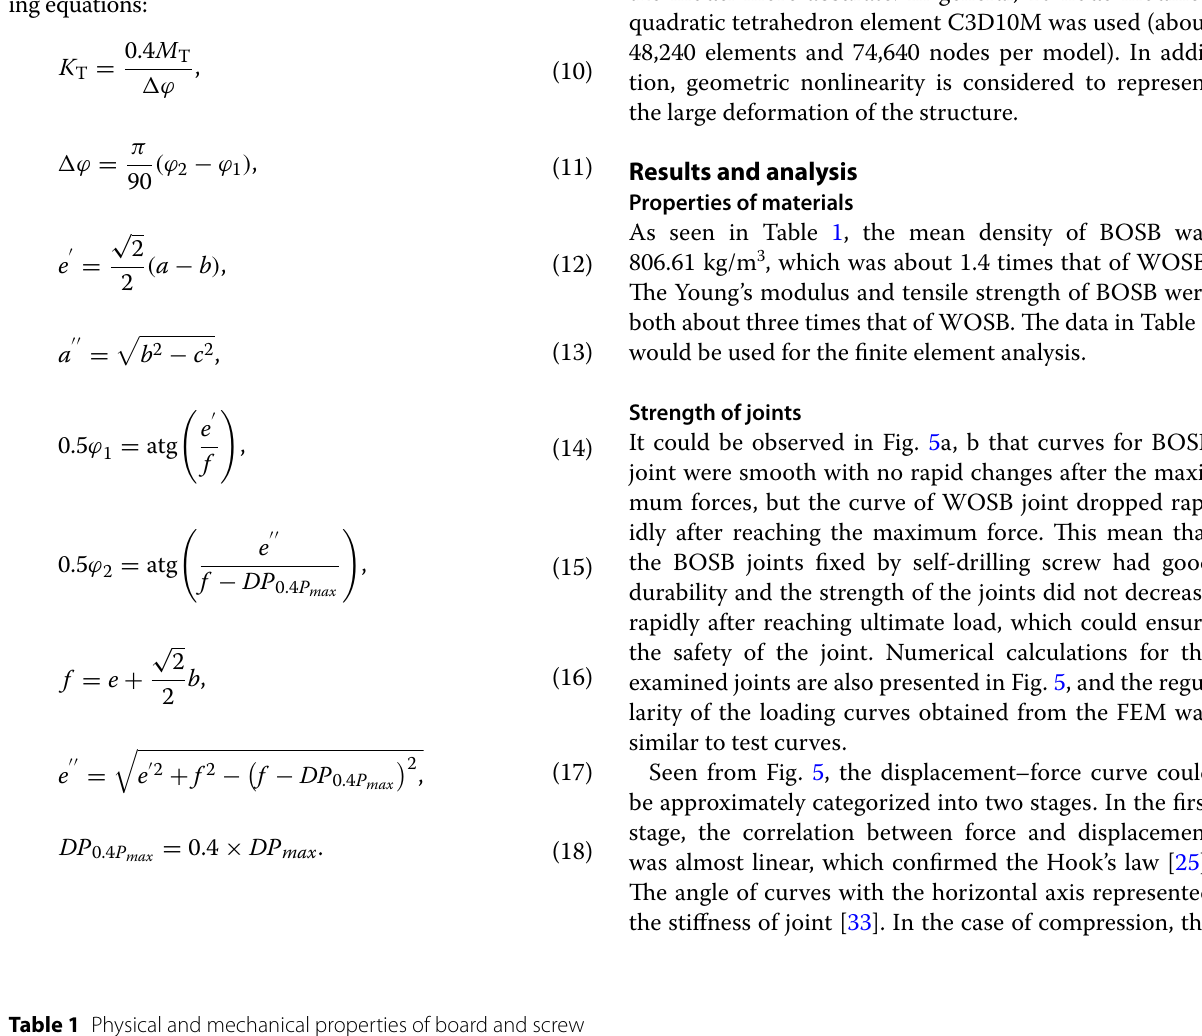
Table 1 Physical and mechanical properties of board and screw